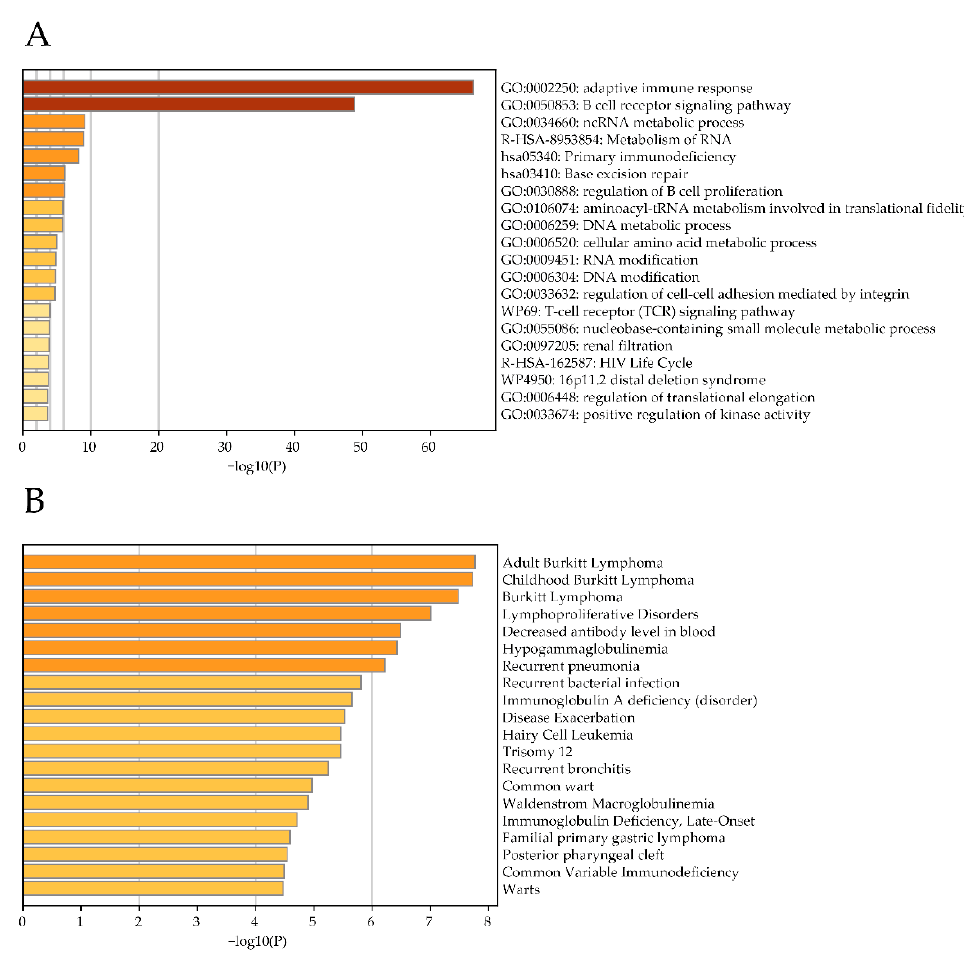
Figure 3. Analysis of AL928768.3 eRNAs expression in human blood cells. Clustering of genes co-expressed with eRNAs of AL928768.3 in blood cells by functional ontologies ( A ) and by disease association ( B ).